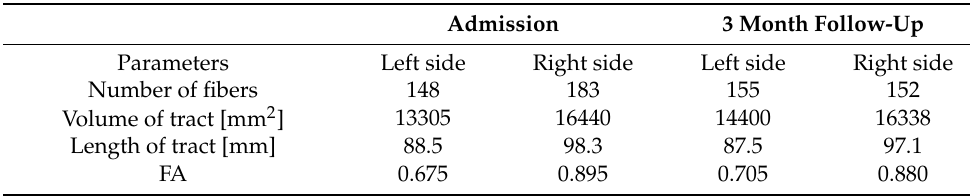
Figure 7. Anatomy of the patient’s uncinate fasciculus (UF) at 3 months following stroke. ( A ) right hemisphere, ( B ) left hemisphere, ( C ) comparison of left and right axial plane of the UF. Table 1. The patient’s morphological data of the uncinate fasciculus (UF) upon admission and three months following stroke.